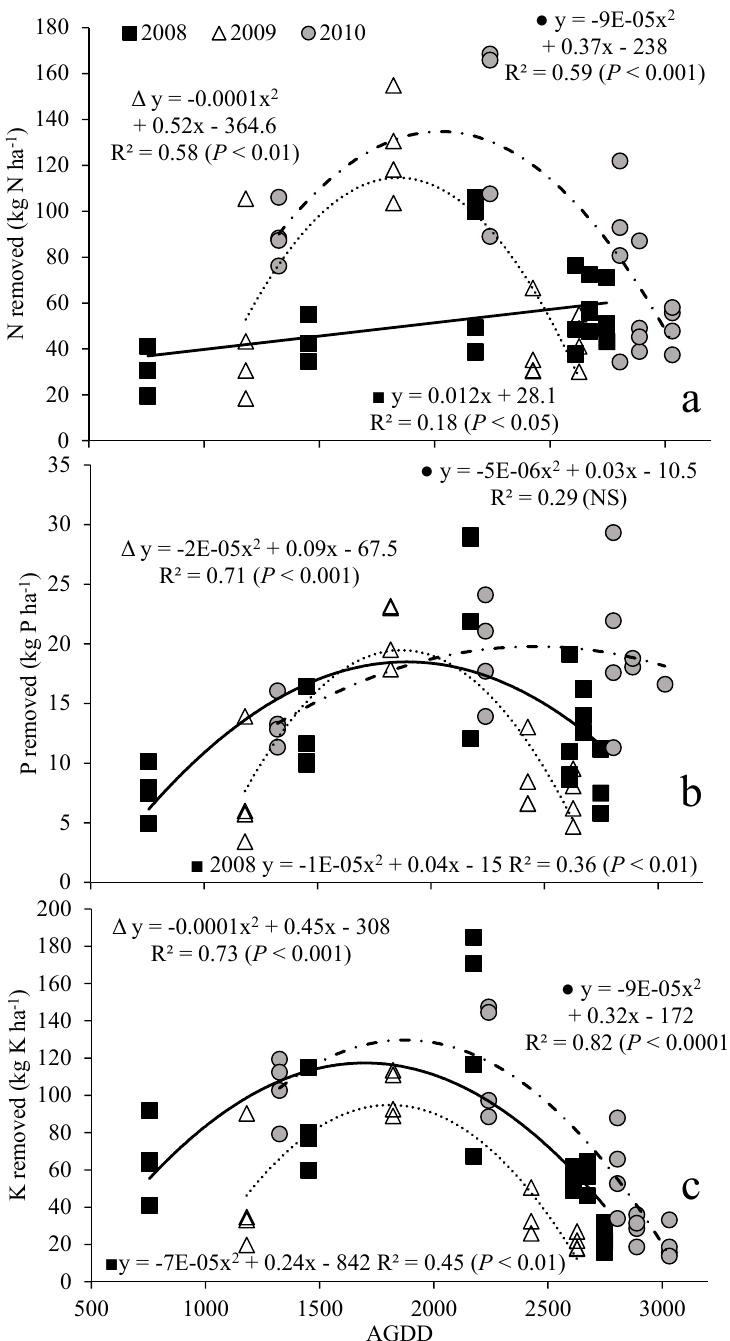
Figure 3. Switchgrass nutrient removal of N ( a ), P ( b ) and K ( c ) (kg ha − 1 ) in aboveground (AG) harvests as a function of AGDD (accumulated growing degree days) in 2008, 2009 and 2010. NS: nonsignificant ( p > 0.05).